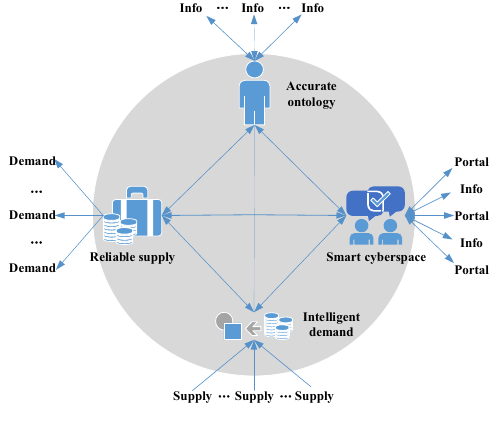
Figure 2. The constitute of personalized portal